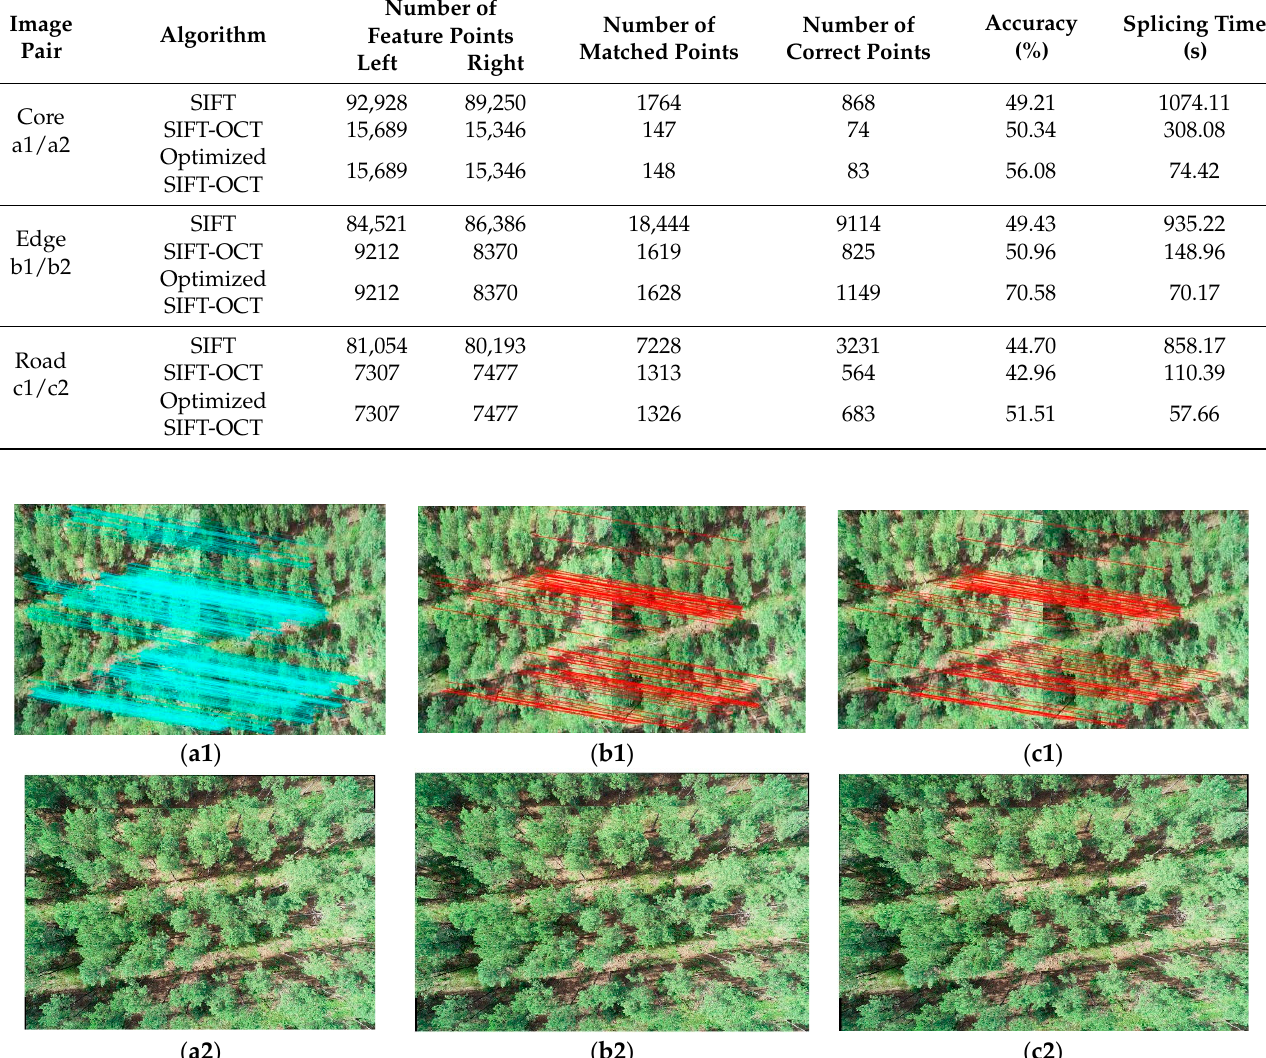
Table 1. Comparison of image stitching algorithm efficacy.